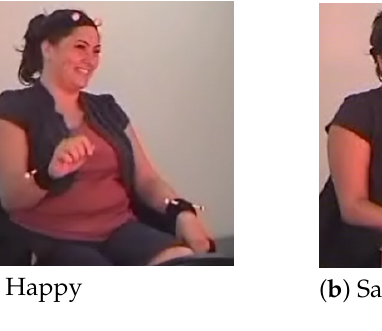
Figure 7. Illustration of examples of four emotions from IEMOCAP database